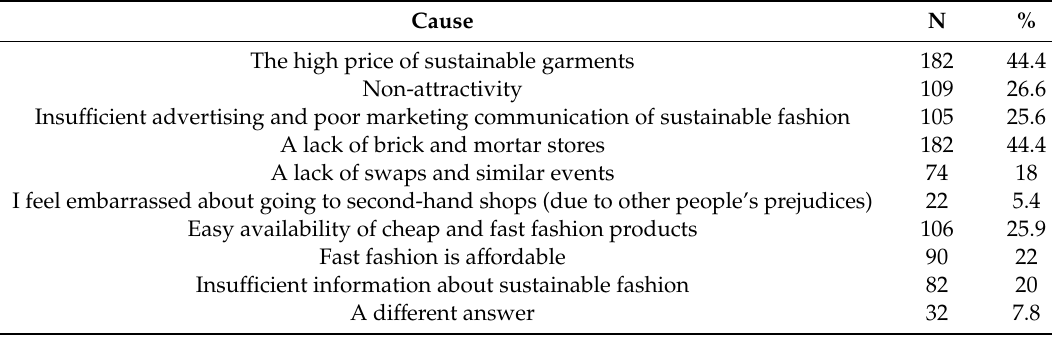
Table 3. The main causes of consumers’ disinterest in sustainable fashion